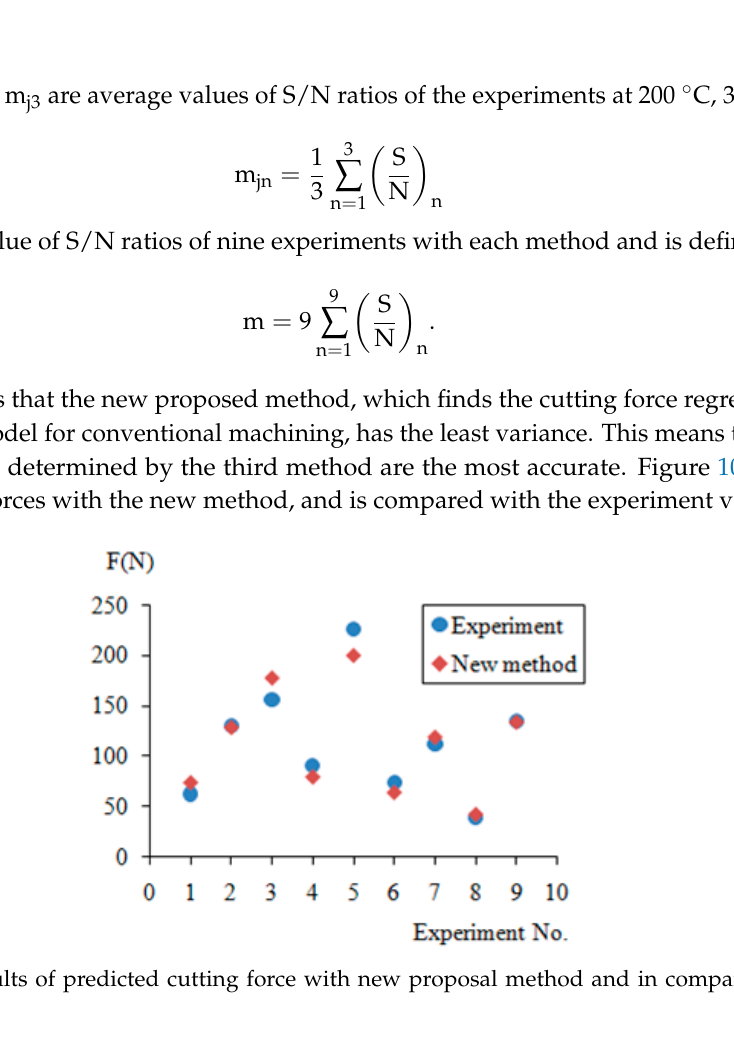
( c ) Figure 11. The relationship between F with V c , f and t at different temperatures ( a ) with fixed cutting speed, ( b ) with fixed feed rate, ( c ) with fixed cutting depth.